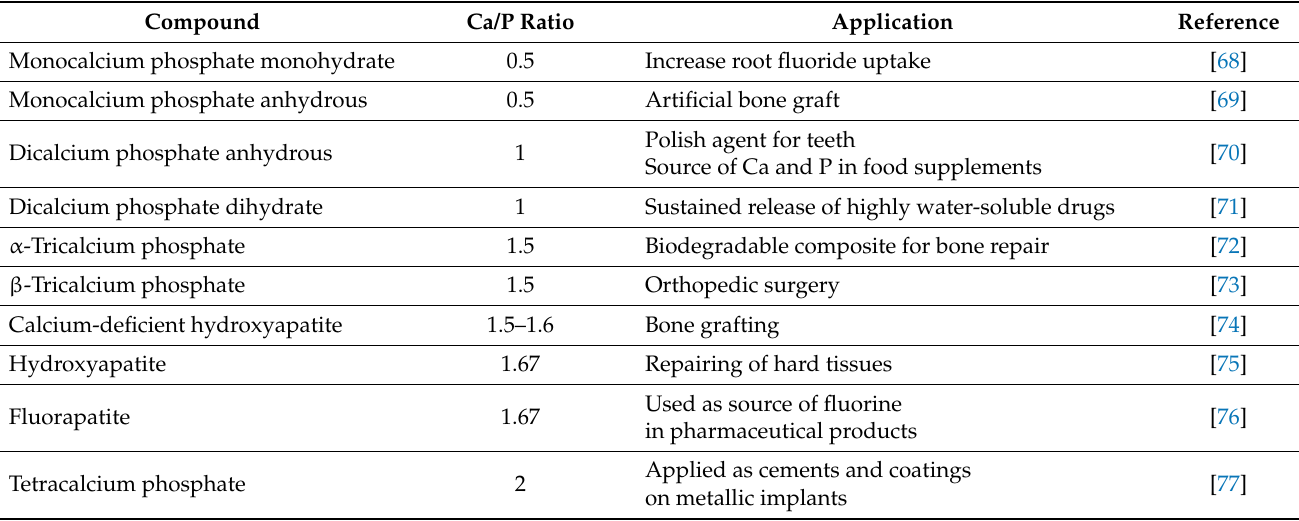
Table 2. CaP-based compounds, Ca/P ratio, and pKs values